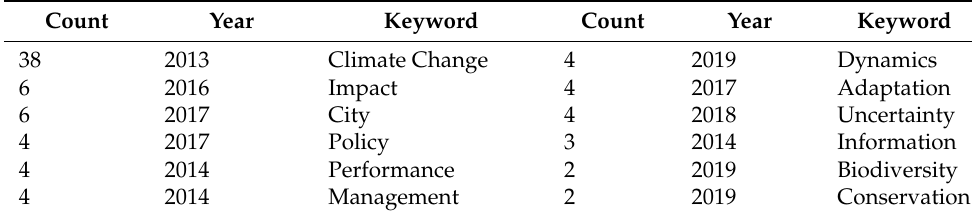
Table 6. Summary of the